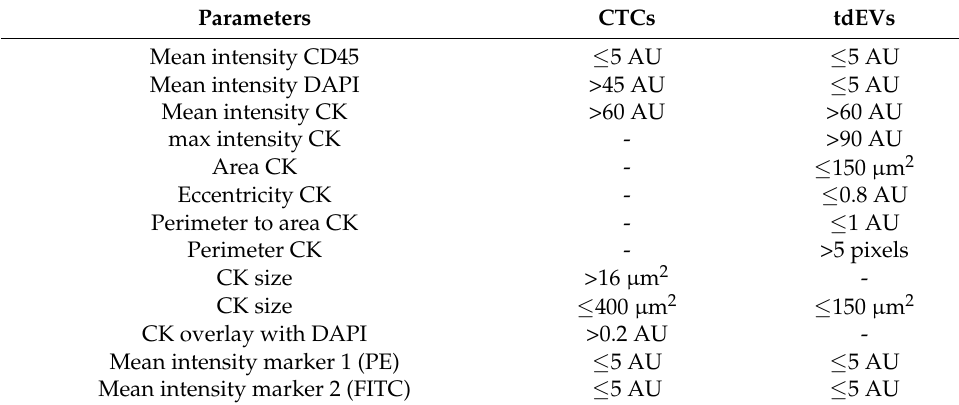
Table 1. ACCEPT gates for CTC and tdEV